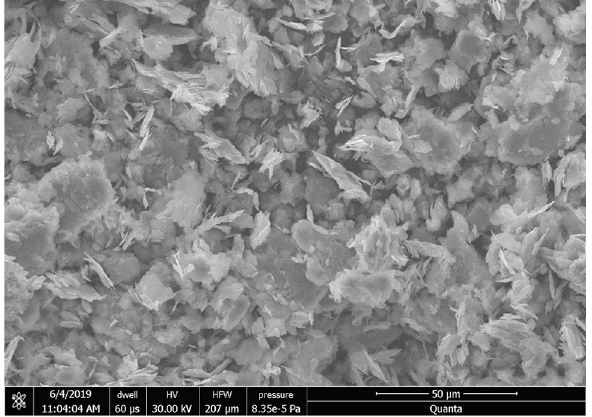
Fig. 3 Photographic image of splinter particles of carbonyl iron obtained by grinding a powder with spherical particles in n -hep- tane followed by electroplating with metal nickel (the concentra- tion of nickel in the pure powder is 2.46 wt%)